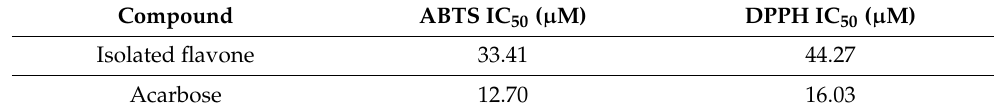
Table 3. In-vitro antioxidant activity of the isolated flavone.